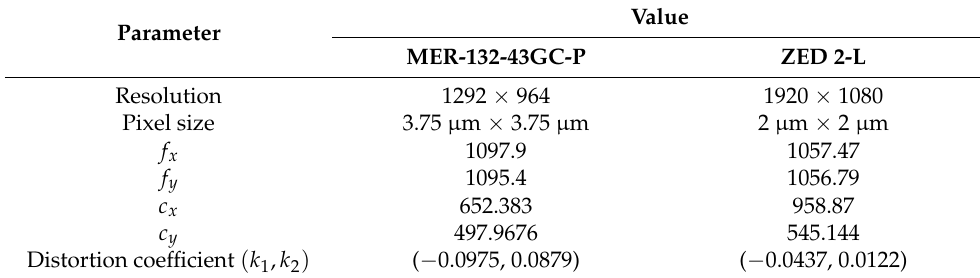
Table 2. Main parameters of MER-132-43GC-P and ZED 2